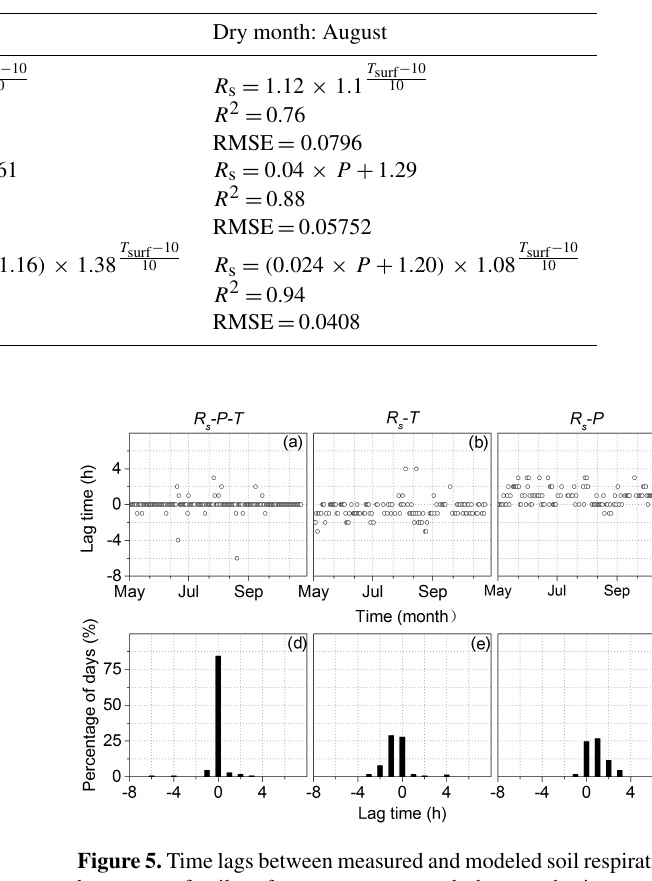
Figure 4. Relationship between soil water content (SWC) and the relative importance (RI) of soil-surface temperature and photosyn- thesis at an Artemisia ordosica -dominated site as a function of soil respiration ( R s ) .